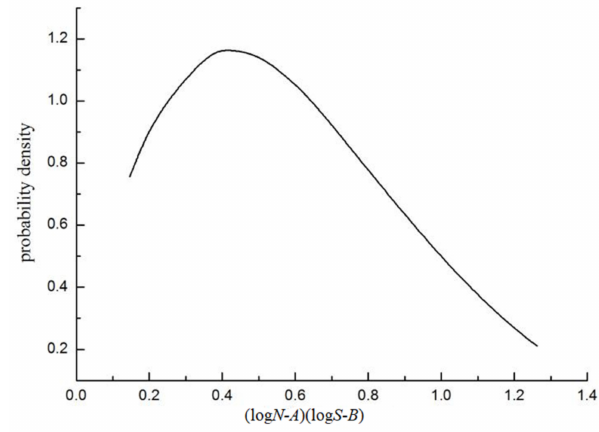
Figure 4. Probability density function of HY-type sucker rod.